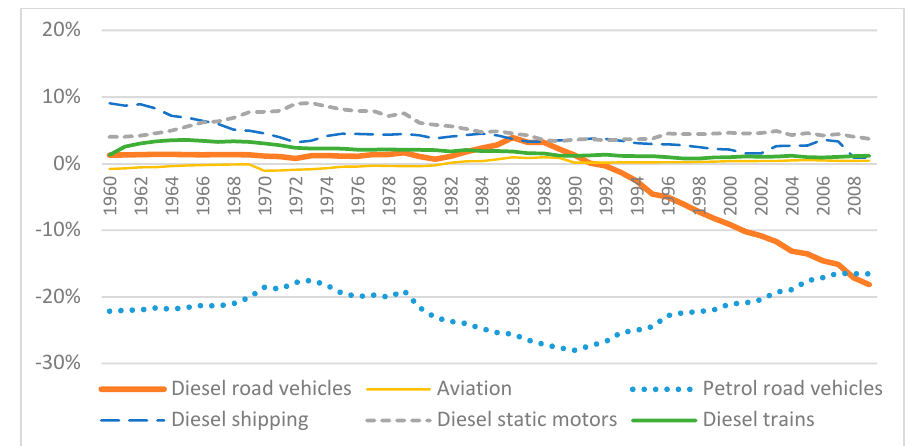
Figure 8. Difference in useful exergy between base and alternative methods for each mechanical drive category (except coal trains), divided by the total mechanical drive useful exergy consumption under the base method, expressed as a percentage.